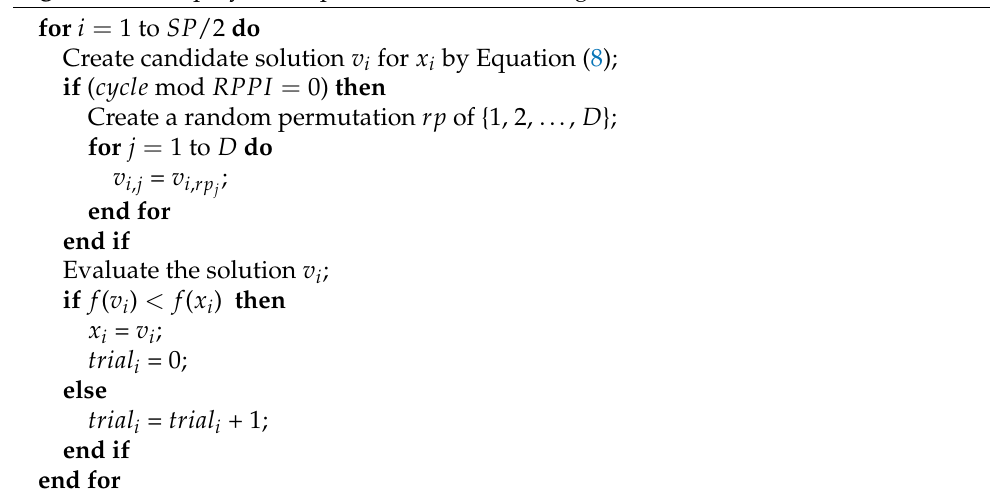
Algorithm 1 Employed bee phase of the SB-ABC